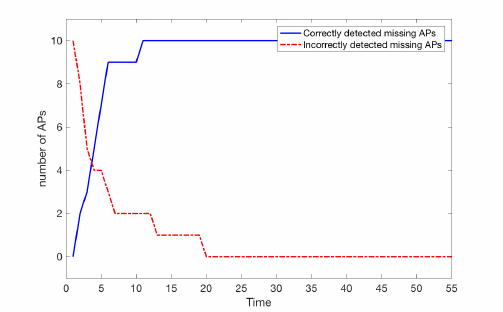
Figure 16. Number of missing APs detected (10 APs are not working and 10 APs are turned on